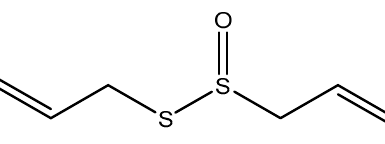
Figure 4. Chemical structure of